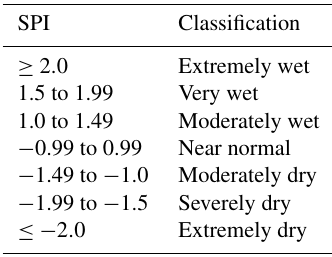
Table 2. Classification of drought conditions according to the SPI values.